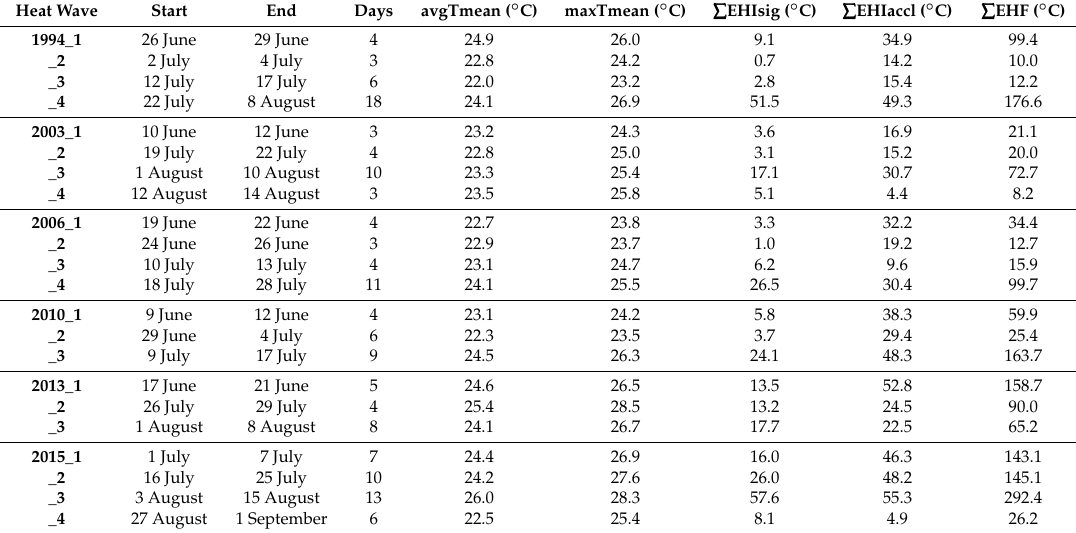
Table 1. Characteristics of heat waves within six years with the longest total heat-wave duration during 1994–2015 in the Czech